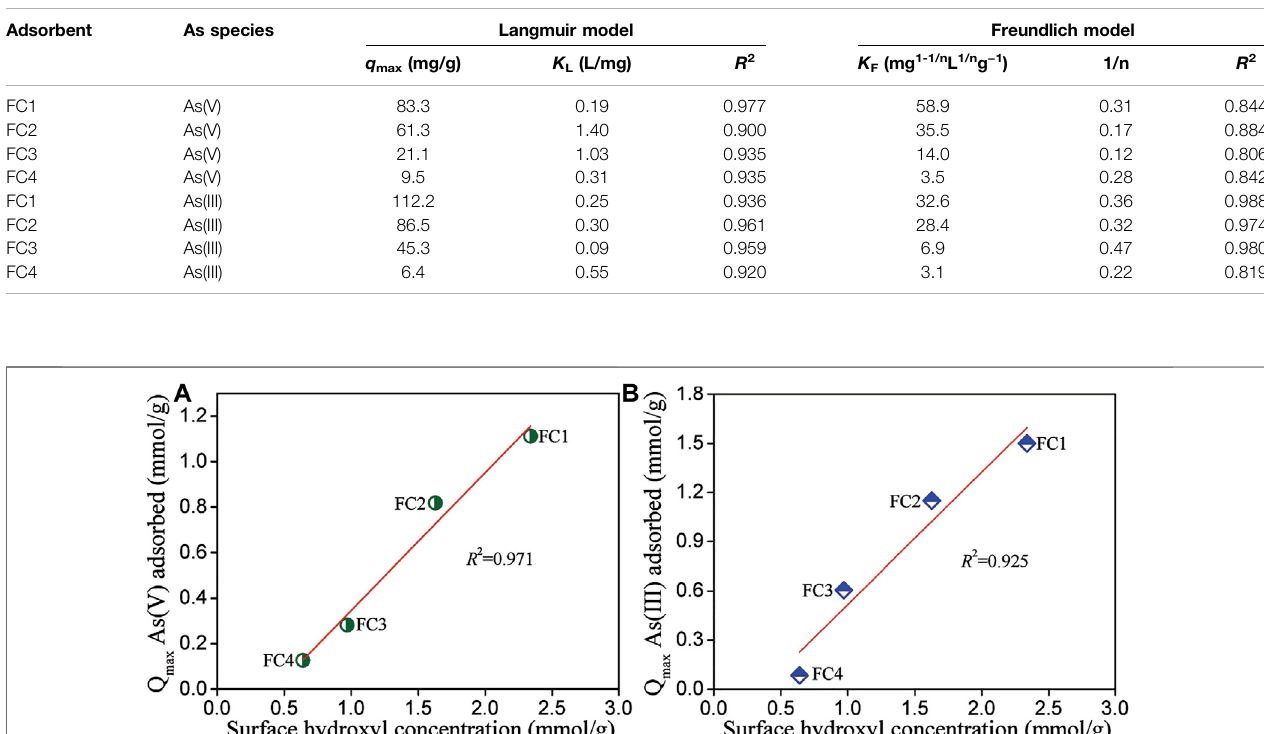
Frontiers in Chemistry |